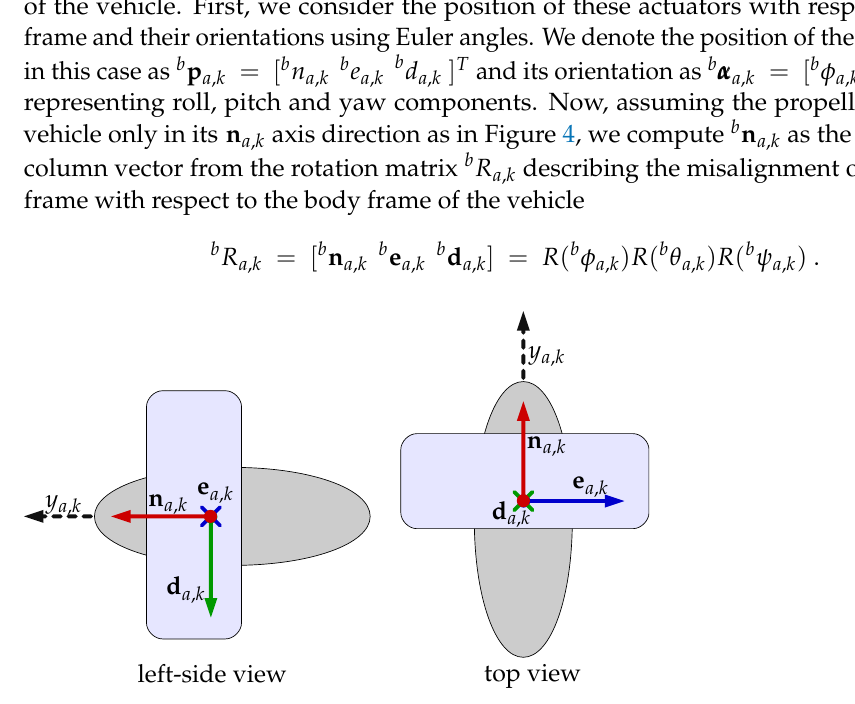
Figure 4. This image shows the direction of the force generated by a propeller. The left view shows a sideways view from the left of the propeller, the right view gives the top view. Observe that the output force vector y a , k is always aligned with the n a , k